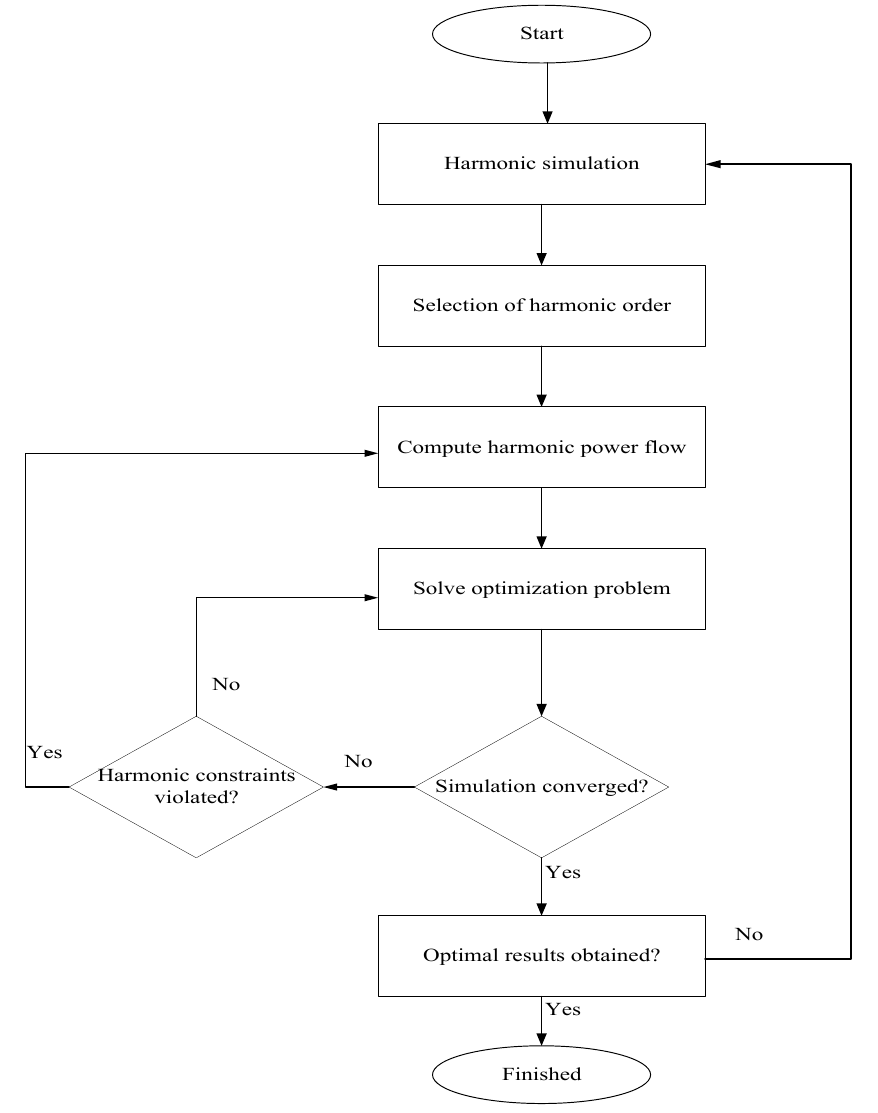
Figure 1. Simulation procedure flowchart.